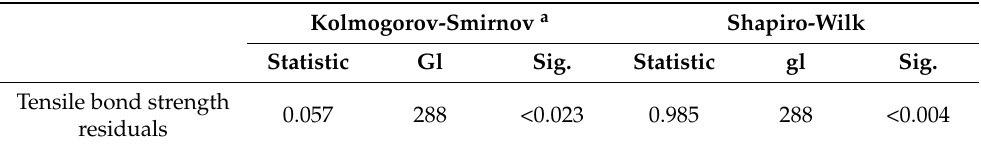
Table 7. Normality tests of tensile bond strength